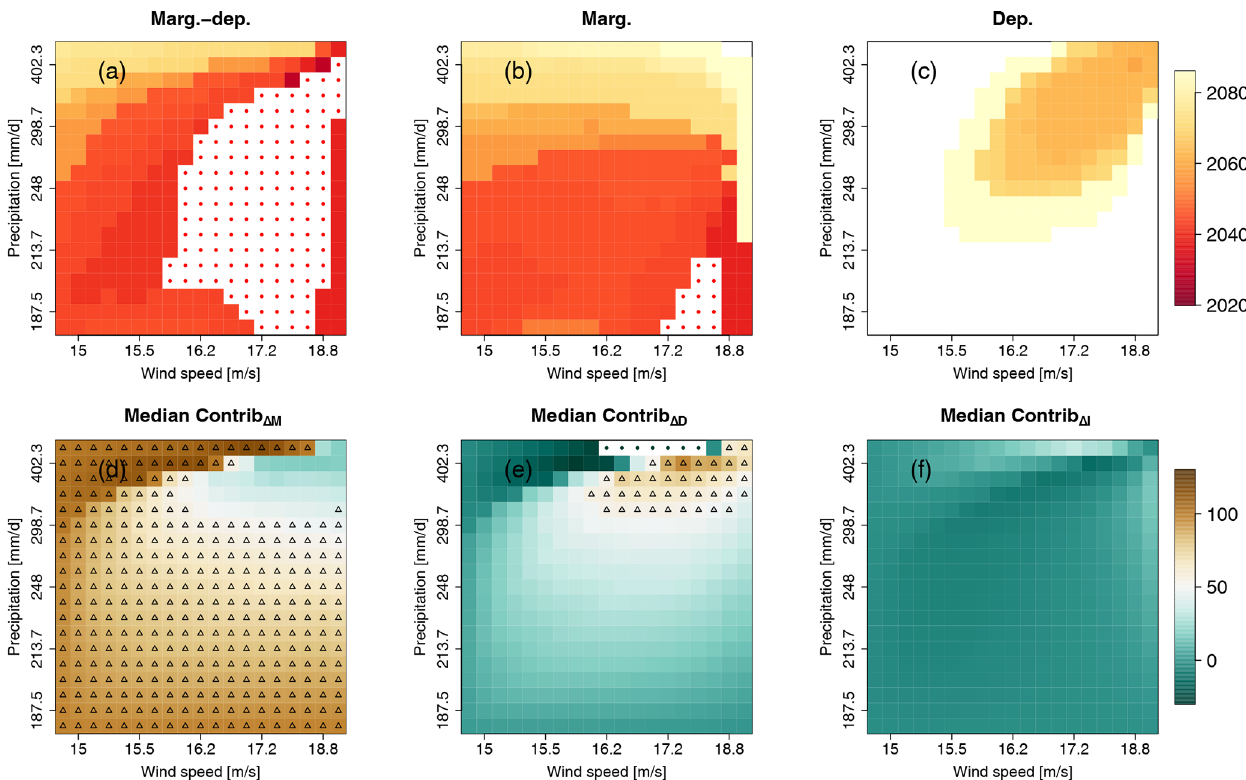
Figure 6. CNRM-CM6 (a–c) time of emergence (at 68% confidence level) for compound wind and precipitation extremes due to changes of (a) both marginal and dependence properties, (b) marginal properties only, and (c) dependence properties only. White cells indicate that no time of emergence is detected, while white cells with red points indicate time of emergence values before 2020. (d–f) Matrices of median contributions of the (d) marginal, (e) dependence and (f) interaction terms. Results are presented for varying exceedance thresholds between the 5th and 95th percentile of compound wind and precipitation extremes data. Upper triangles show where the contribution is ≥